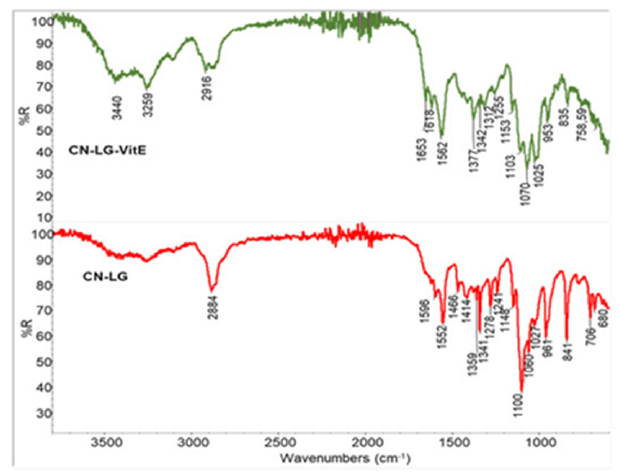
Figure 9. Infrared spectrum of the complexes CN-LG and CN-LG-VitE (Reprinted with permission from Panariello et al. (2021) MDPI [93]).